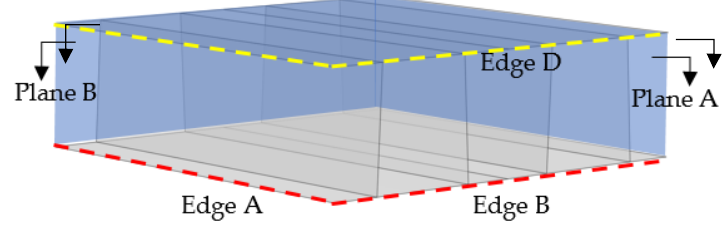
Figure 4. Origin shell model for thermal buckling analysis.